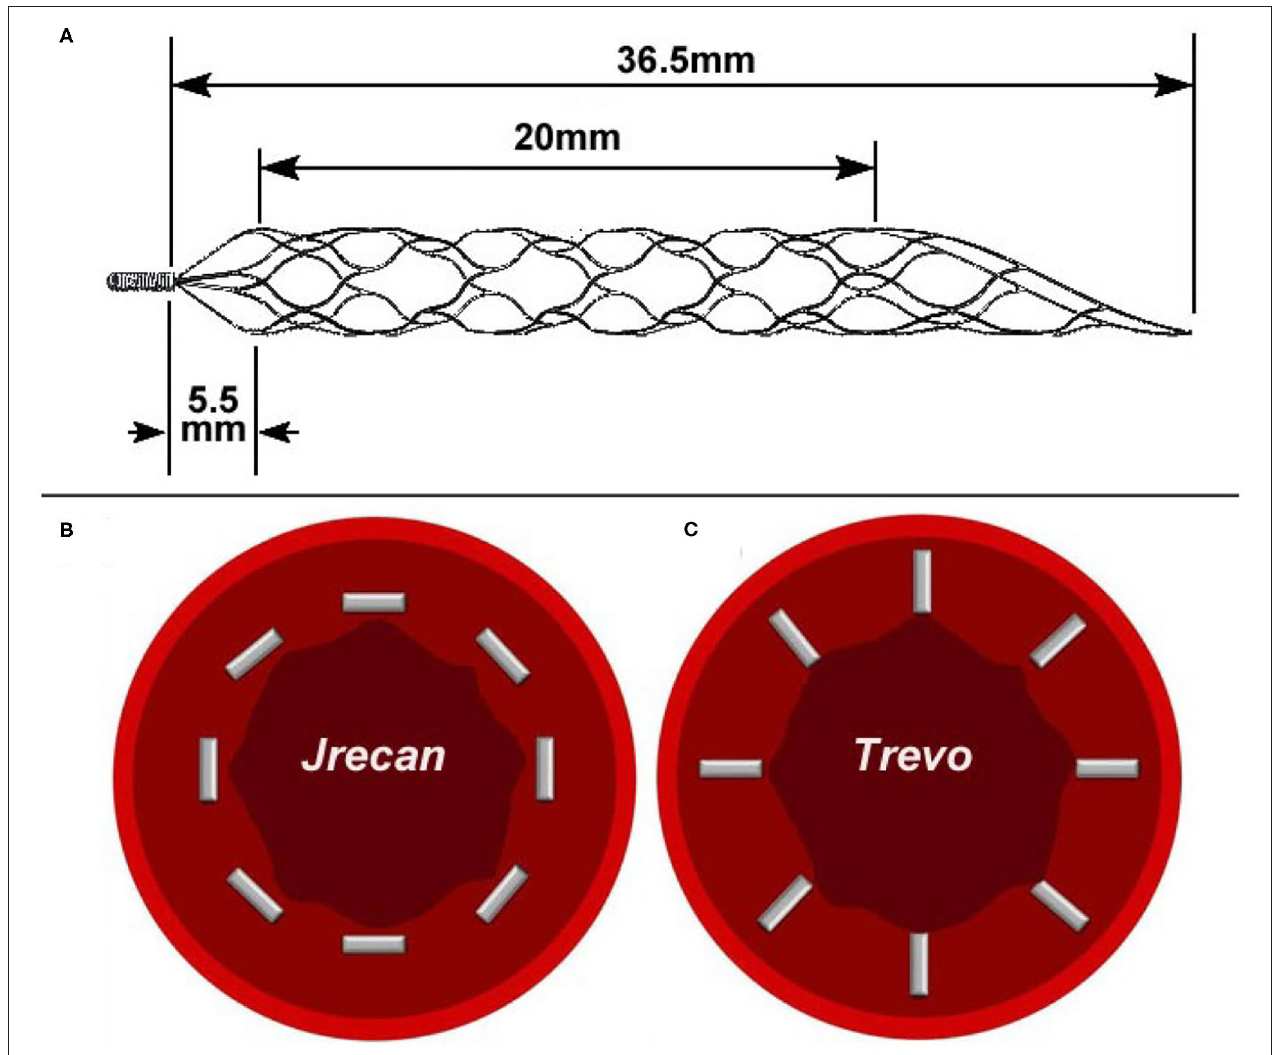
FIGURE 1 | Physical picture and trabecular structure diagram of two devices. (A) The Jrecan ® device has an optimized grid design with a large mesh area (11.7 mm 2 ) and it is designed to optimize the radial support force (0.120 N/mm). The area of the mesh at the distal end of the device is gradually reduced and formed into a conical shape. (B) The horizontal trabecular structure of Jrecan device. (C) The vertical trabecular design of Trevo